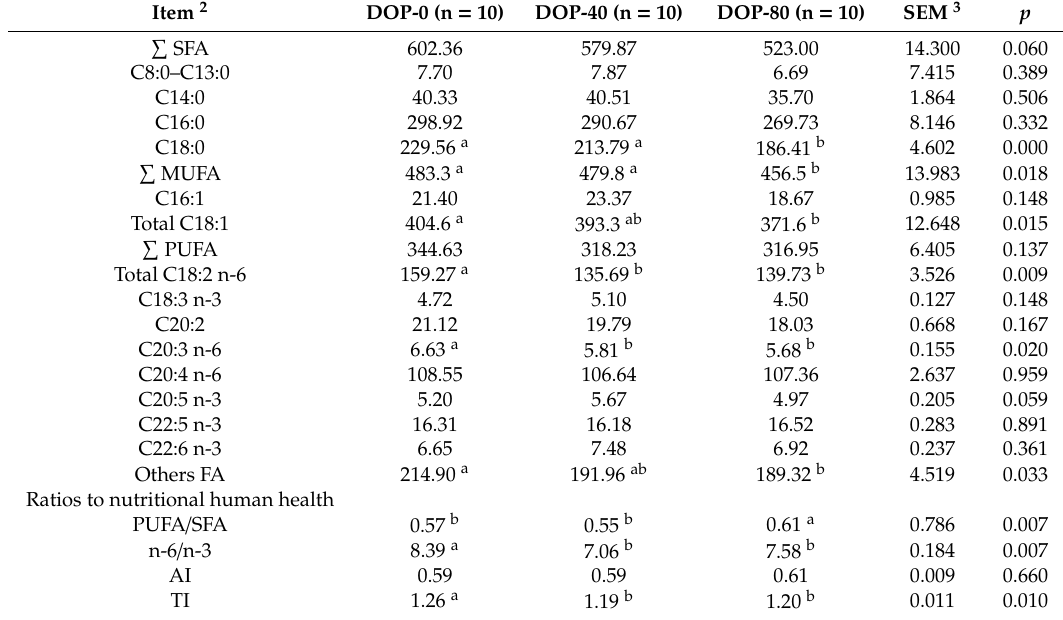
Table 4. Fatty acid (FA) composition of the meat of suckling goat kids (expressed as mg FA / 100g fresh meat) according to the use of dehydrated orange pulp in feeding dams 1 .